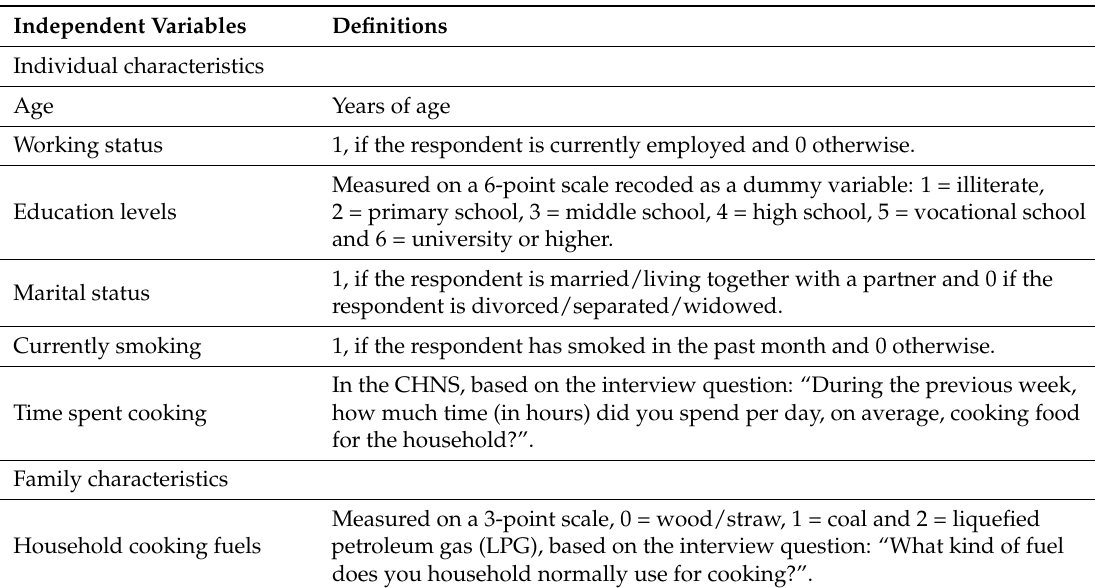
Table A1. Definition of independent